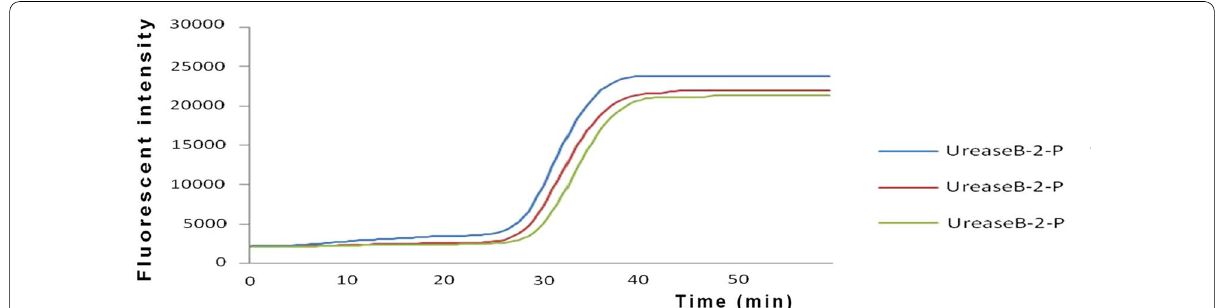
Fig. 4 The repeatability of real‑time fluorescence LAMP